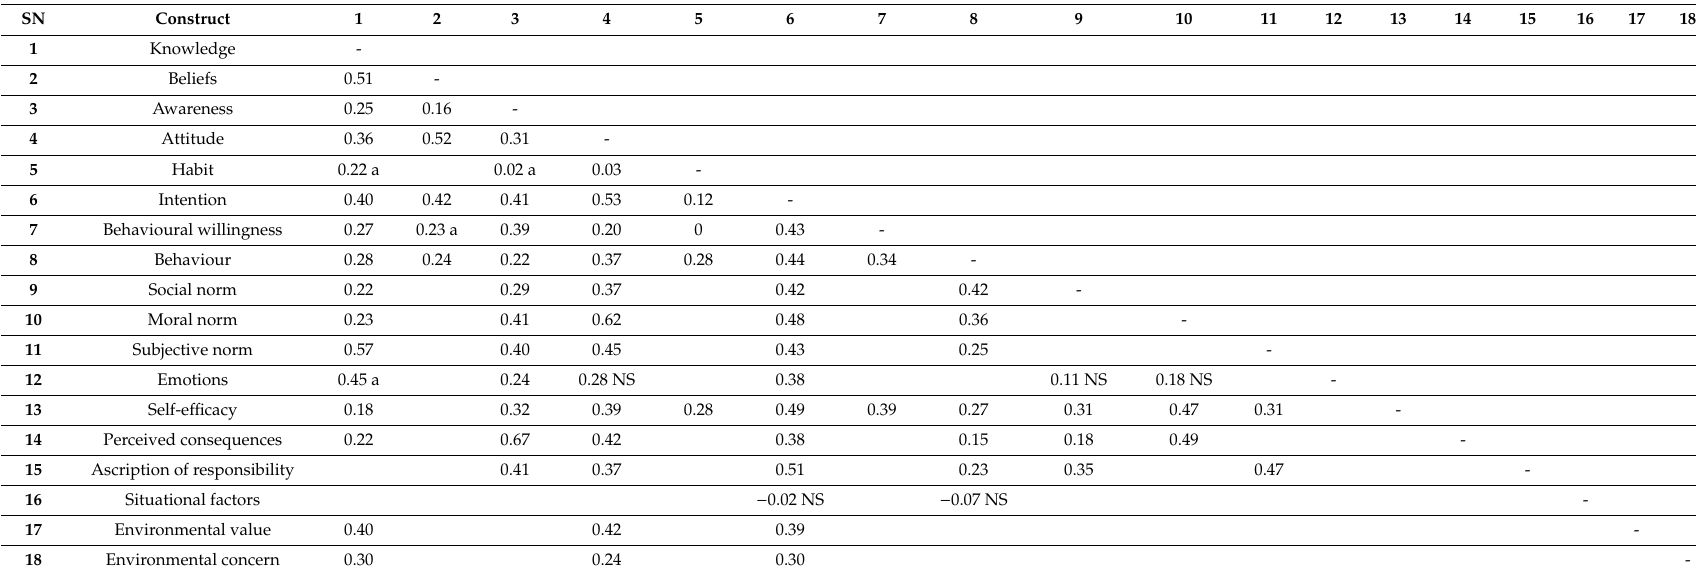
Table 5. Pooled correlations for all environmental policy